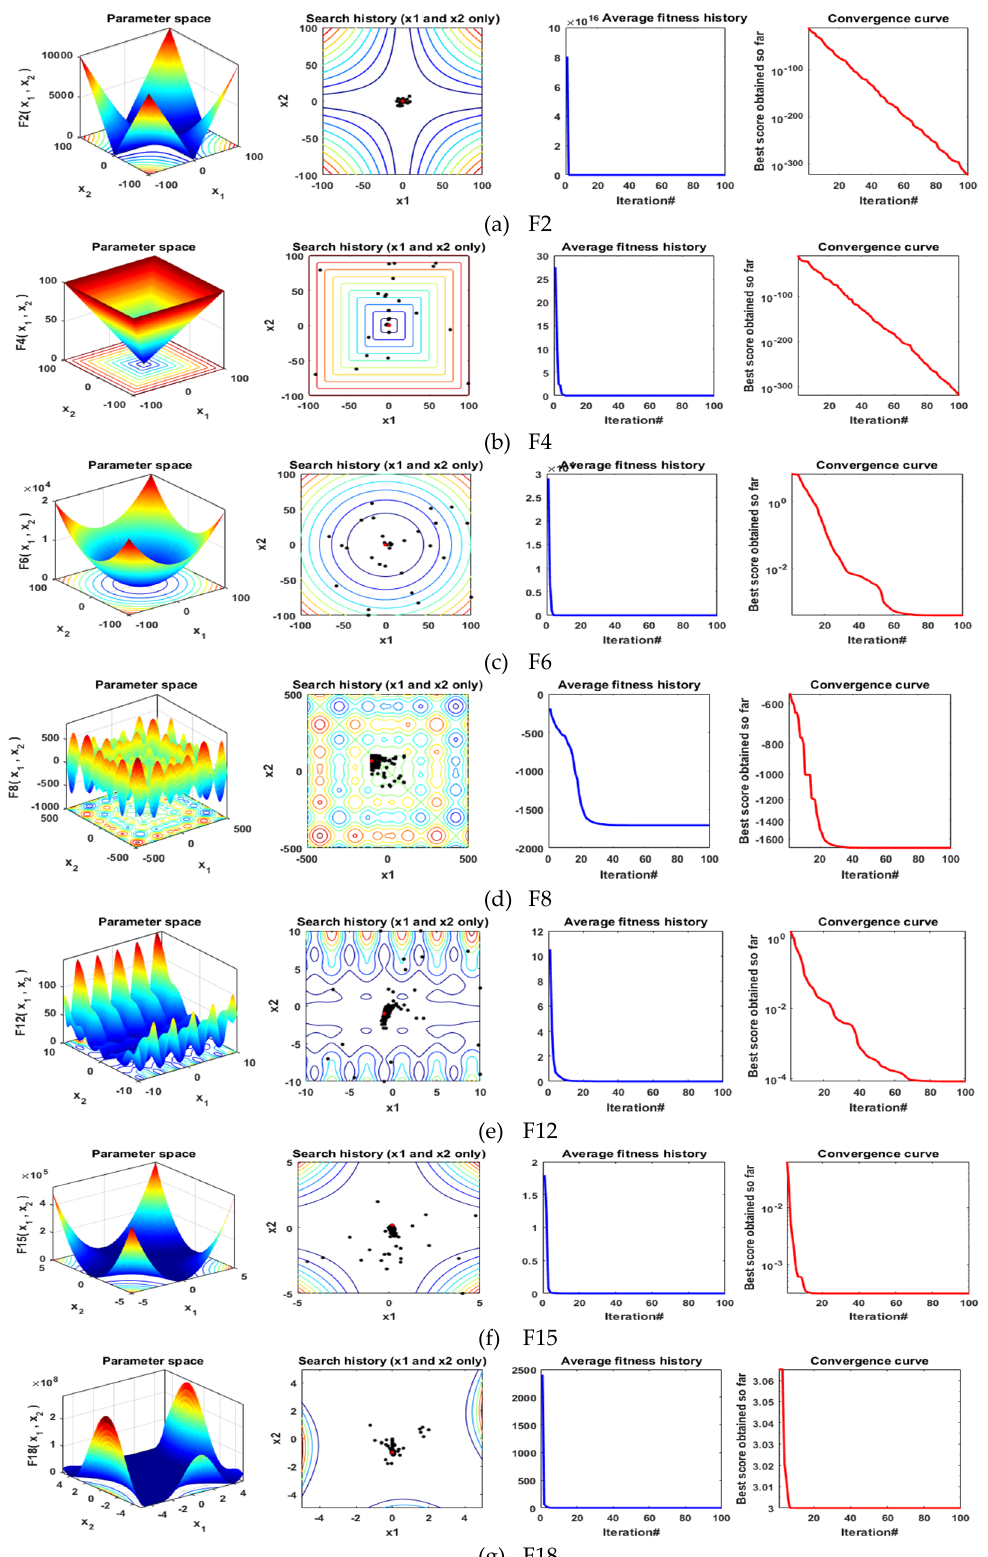
Figure 9. Qualitative metrics for the ( a ) F2, ( b ) F4, ( c ) F6, ( d ) F8, ( e ) F12, ( f ) F15, and ( g ) F18 functions: 2D views of the functions, search histories, average fitness histories, and convergence curves.